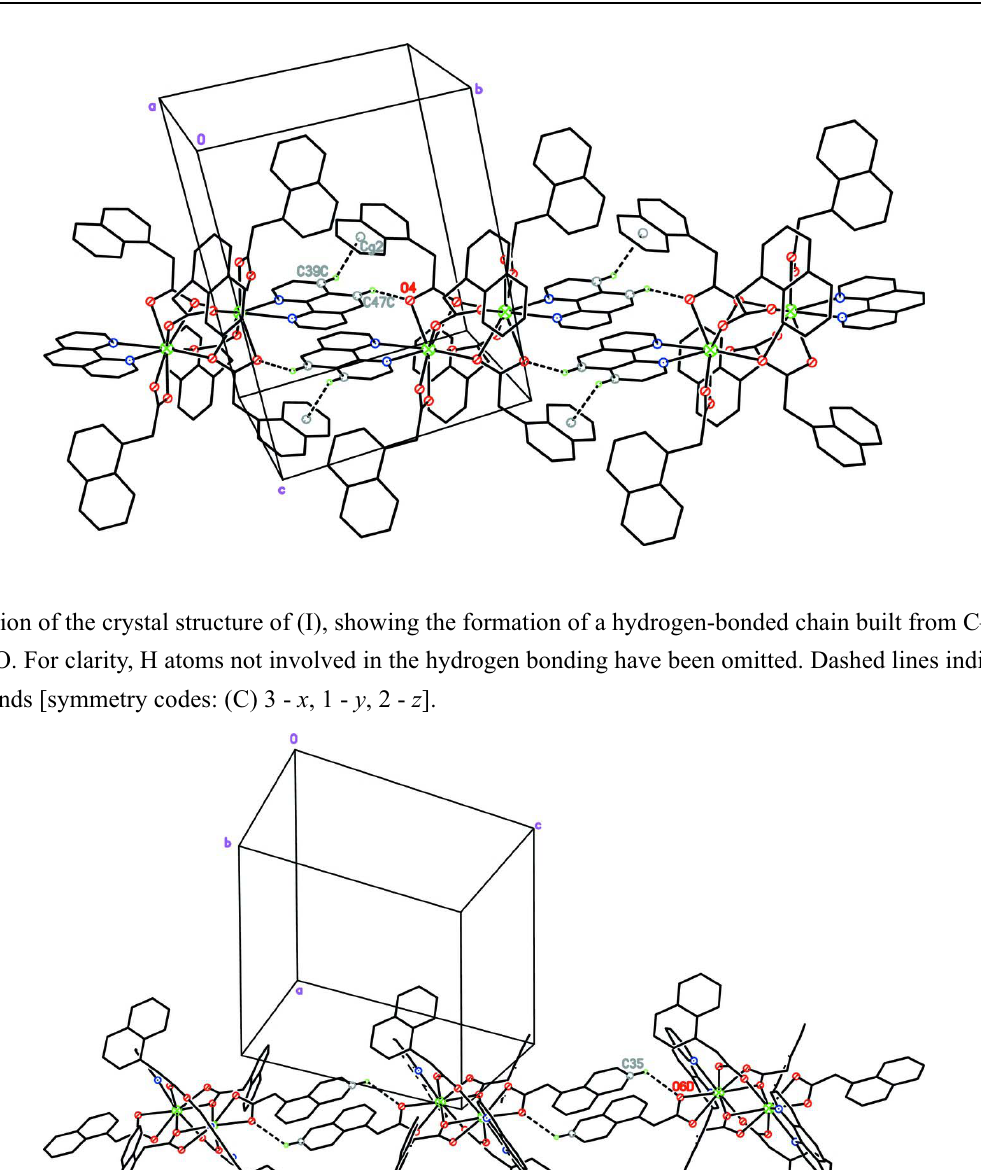
Triclinic, P 1 Hall symbol: -P